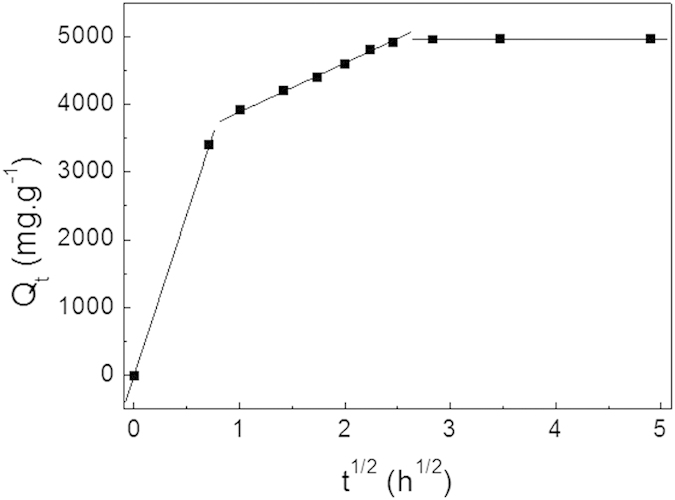
Intraparticle diffusion kinetic plot for the adsorption of MG into ZnO/ZnFe2O4 nanostructures.